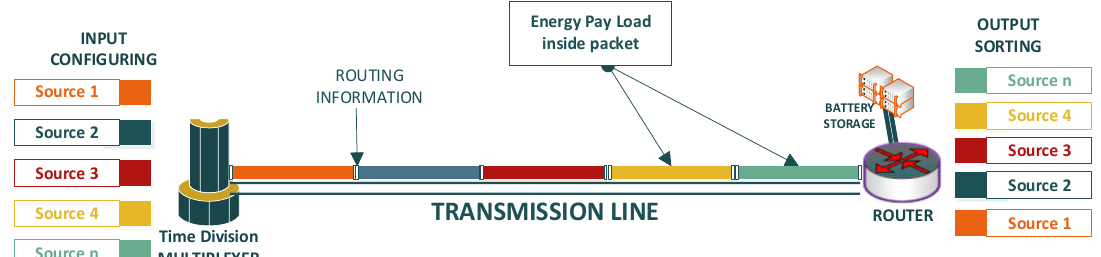
Figure 6. Multiport converter (MPC)-based E-router model.